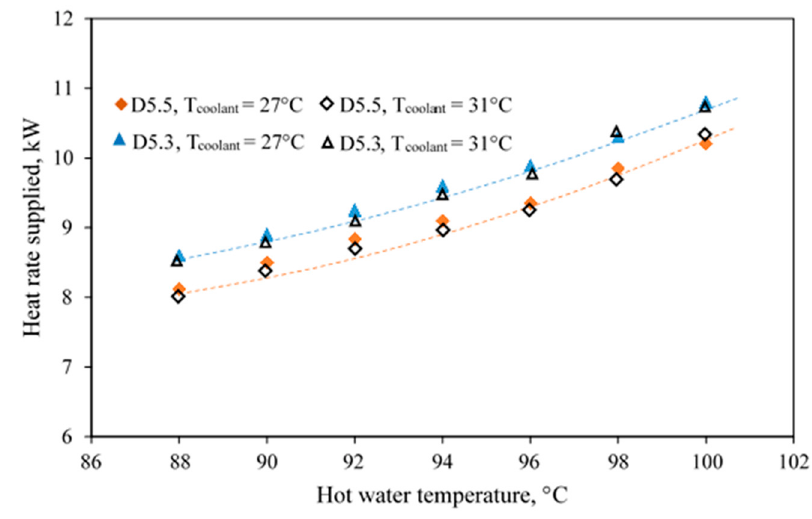
Figure 5. The heat rate required for operation influenced by different primary nozzles .